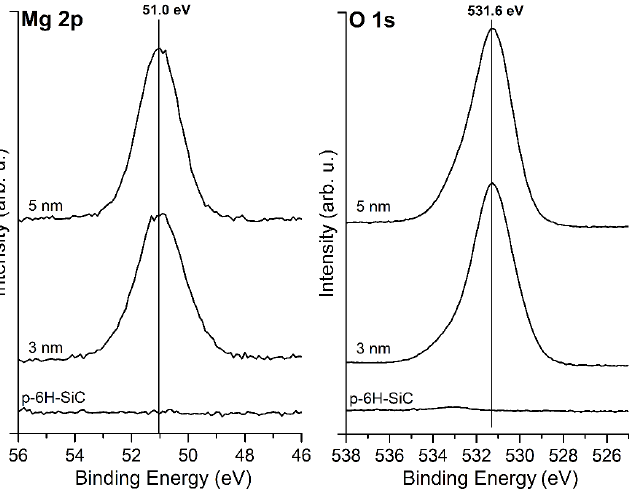
Figure 2. XPS spectra of Si 2p and C 1s core level lines for bare SiC(0001) surface and covered with MgO layers of an average thickness of 3 and 5 nm. Both peaks remain almost in the same positions after MgO deposition.